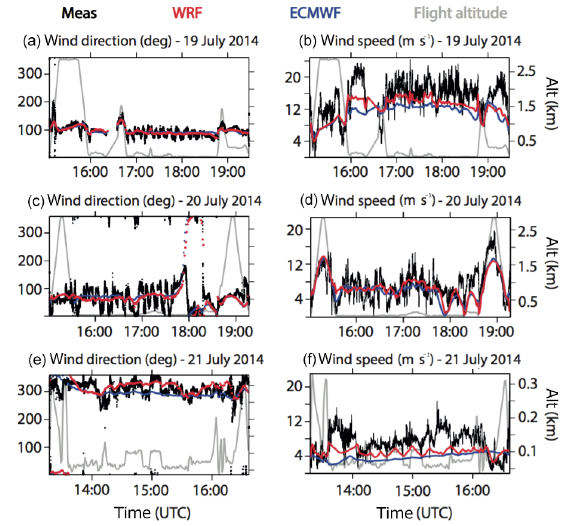
Figure 2. Measurements of wind direction and wind speed during the plume sampling flights (black). The modeled wind speed and direction interpolated in space and time to the location of the aircraft are shown for the ECMWF analysis (blue) and WRF model (red). The flight altitude is shown in grey.